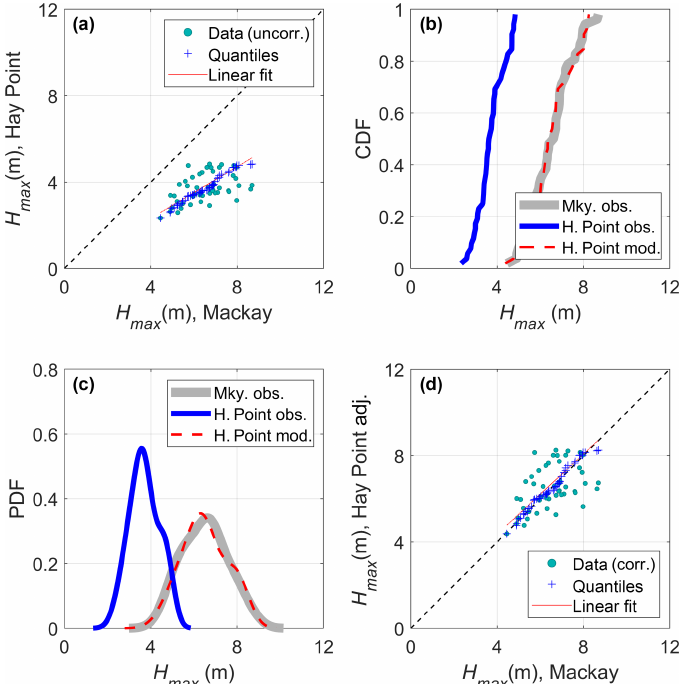
Figure 2. Example of the CDF mapping approach used to extrapolate an estimate of H max at the Mackay wave buoy, using data from the Hay Point buoy. (a) shows the raw observations (green) and quantiles (blue) of H max at both sites during the overlapping period; (b) shows the cumulative distribution of H max at Hay Point (observed, blue line), at Mackay (observed, grey line), and at Hay Point (CDF mapped to Mackay, red dotted line); (c) shows the same for the probability density of H max , and (d) shows the CDF-adjusted Hay Point data against the original Mackay data, demonstrating their improvement as a predictor for H max at Mackay, compared to (a)